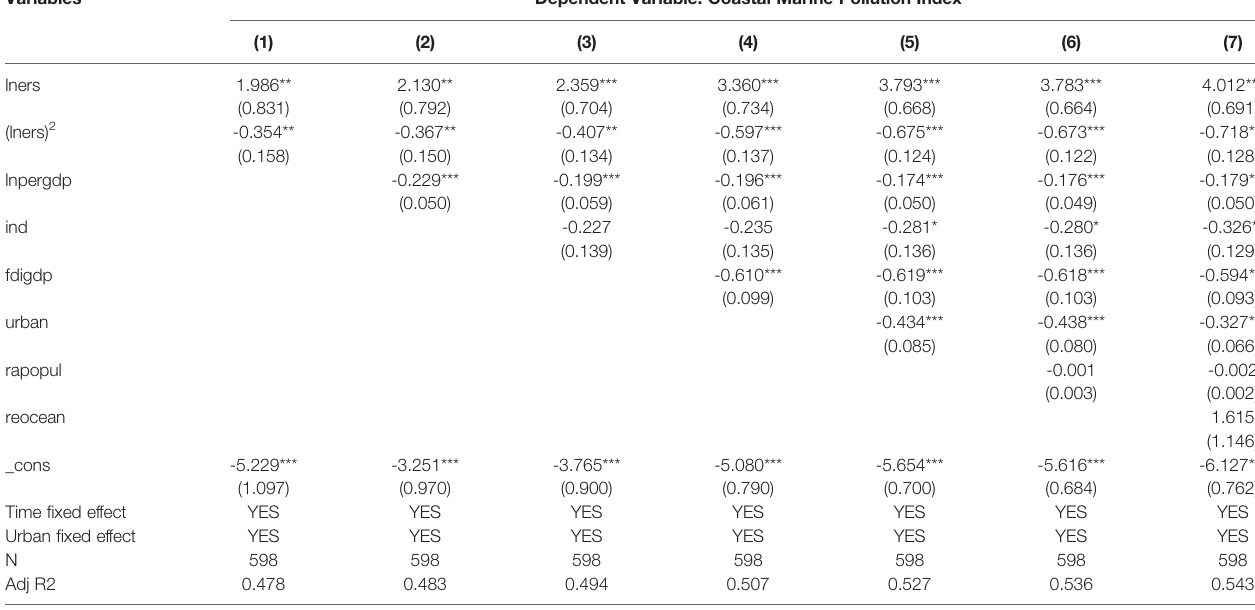
TABLE 2 | Benchmark estimation